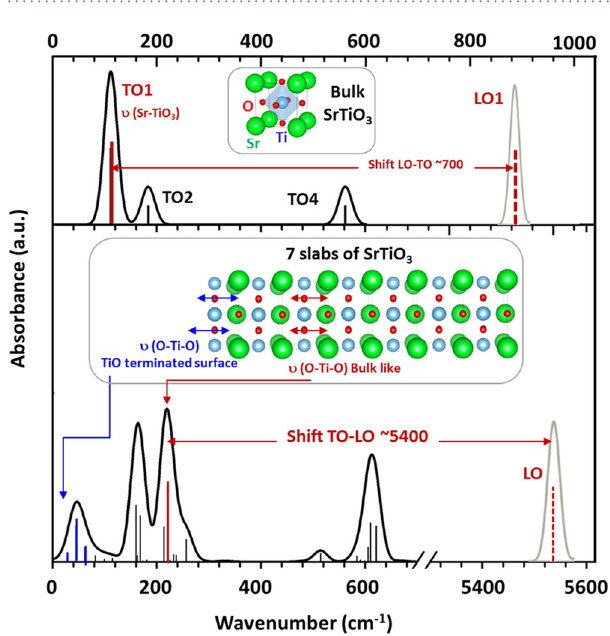
Figure 3. Main optical modes contributing to the large static dielectric constant for STO bulk (top) and for a slab of 7 layers under − 1.305% strain (bottom). The bulk TO modes are represented as black and red sticks. Meanwhile, only the large LO-TO shift for the TO 1 mode (shift ~700 cm) is illustrated with a red arrow. At the bottom of the figure, the main optical modes for a 7 layers slab under − 1.305% strain are presented. The black sticks represent modes which derive their intensities from atoms further from the surfaces (bulk like modes). The blue sticks are transverse modes from atoms at the TiO 2 -terminated surface. The red stick at 210 cm − 1 corresponds to a TO mode from Ti-O bending (bulk like mode). The very large LO-TO shift of the 210 cm − 1 mode (indicated by a red arrow) contributes strongly to the high value of ε (0) // . Insets top and bottom: the elementary cell for bulk and for 7 layers slab (Sr: big green sphere, Ti: medium blue sphere, O: small red